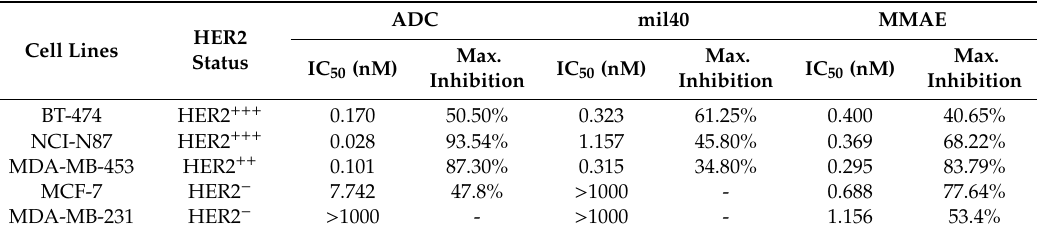
Table 1. Cytotoxicity of ADC, antibody and cytotoxin in cancer cell lines in vitro.